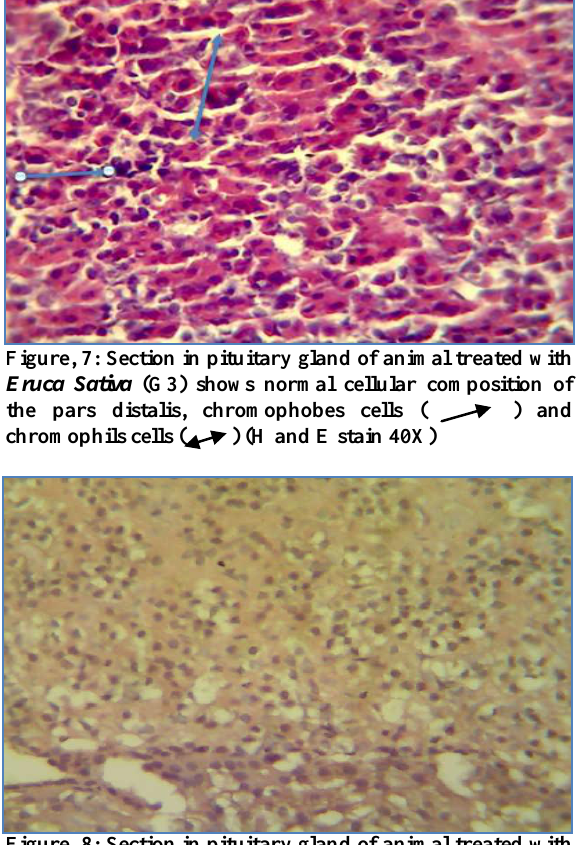
Figure, 8: Section in pituitary gland of animal treated with Eruca Sativa (G3) shows no clear lesions (H and E stain 40X).